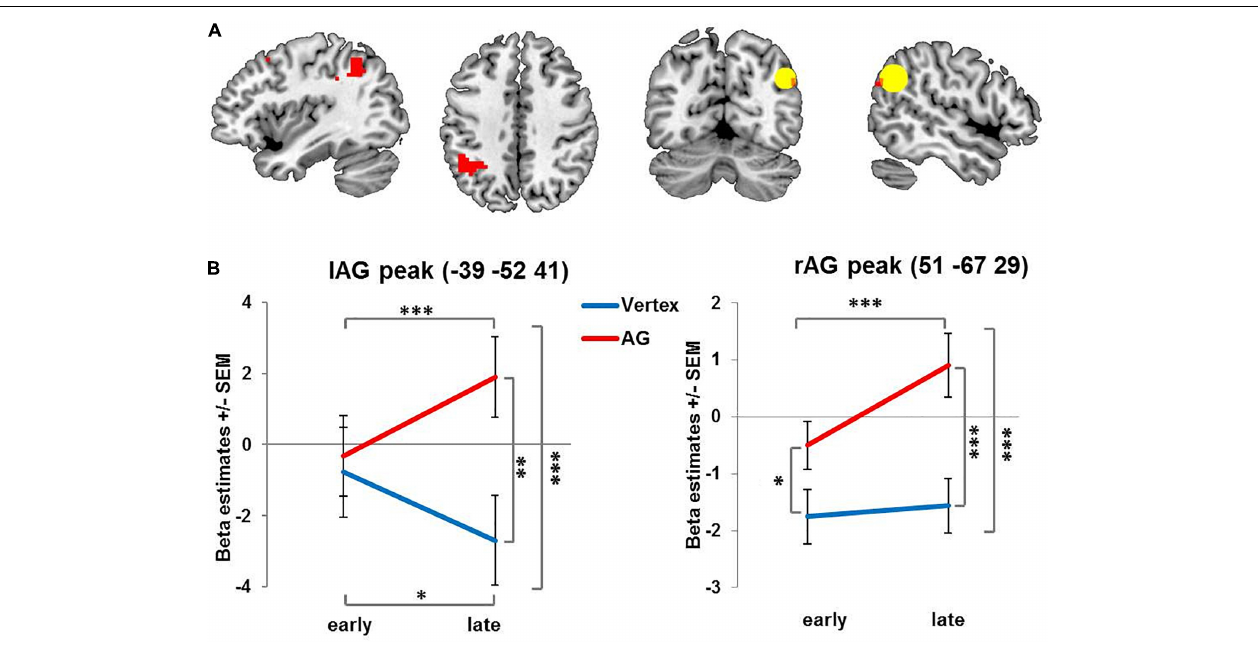
FIGURE 2 | Activation changes over time: Brain regions showing increasing condition-unspecific activity over time after rTMS administered to the right AG compared to vertex. (A) For visualization purposes all images are thresholded at voxel level p = 0.001 uncorrected with red color denoting suprathreshold activation. The ROI centered on the stimulation site in right angular gyrus is indicated by the yellow circle. (B) Left and right AG peak coordinates for interaction of stimulation and time. AG: angular gyrus. SEM: standard error of the mean ∗ denotes p < 0.05, ∗∗ denotes p < 0.01 ∗∗∗ denotes p <